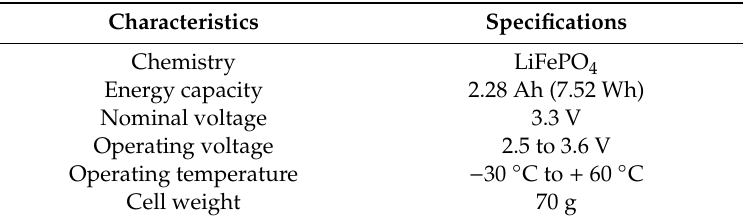
Table 1. LFP Cell Characteristics, according to